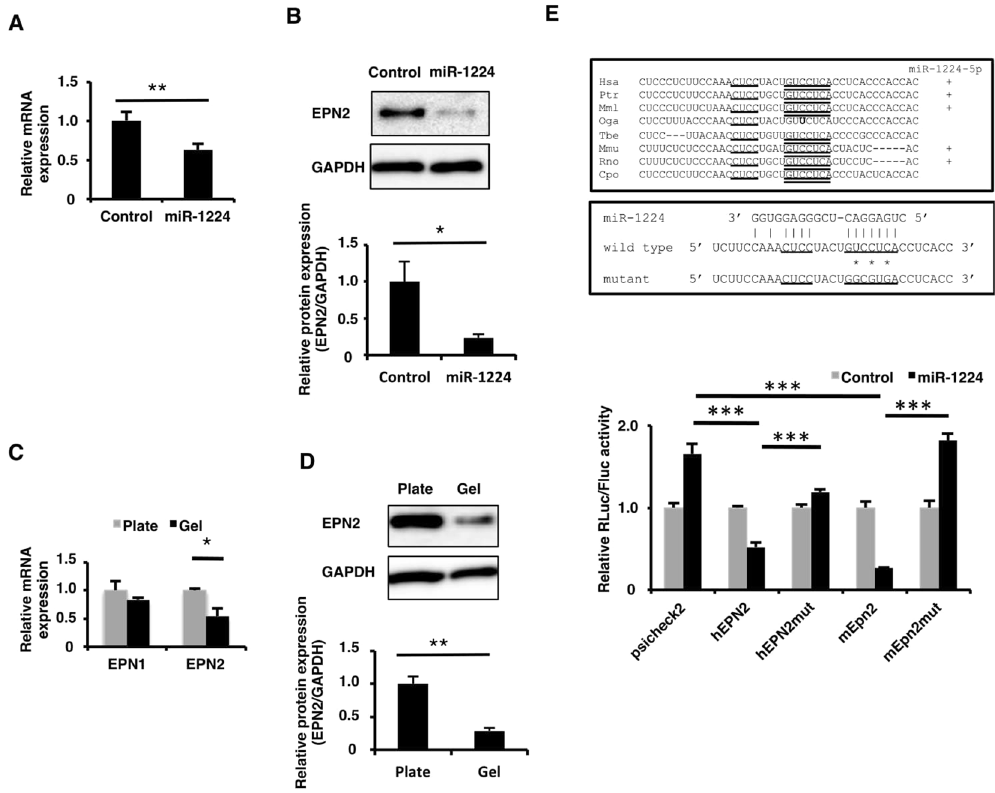
Figure 4. EPN2 expression was suppressed by miR-1224 through its 3 ′ -UTR. ( A ) qRT-PCR analysis of EPN2 mRNA in HUVECs transfected with miR-1224 mimic. Relative expression to the negative control mimic is shown. Bars show the means ± S.D. with ** p < 0.01 (n = 3). ( B ) Western blot analysis of EPN2 protein in HUVECs transfected with miR-1224 mimic. Uncropped versions of gels are provided in Supplementary Information. The normalized signal intensities were shown as relative values to the control. Bars show the means ± S.E. with * p < 0.05 (n = 3). ( C ) qRT-PCR analysis of EPN1 and EPN2 mRNA in M-HUVECs. Relative expression to P-HUVECs is shown. Bars show the means ± S.D. with * p < 0.05 (n = 3). ( D ) Western blot analysis of EPN2 protein in M- and P-HUVECs. Uncropped versions of gels are provided in Supplementary Information. Relative expression to P-HUVECs is shown. Bars show the means ± S.E. with ** p < 0.01 (n = 3). ( E ) Sequence alignment of 3 ′ -UTRs containing the miR-1224 seed-matched sequence. Seed and additional matched sequences are underlined. Species that have miRBase-registered miR-1224-5p are indicated by + in the right column (top panel). Sequence alignment of miR-1224 and the target region of 3 ′ -UTRs. Asterisks indicate the mutated nucleotides (middle panel). Reporter assay was performed in HEK293 cells (bottm panel). Normalized renilla-luciferase activity (Rluc/Fluc) relative to the control empty psiCHECK2 is shown. Bars show the means ± S.D. with *** p < 0.001 (n =